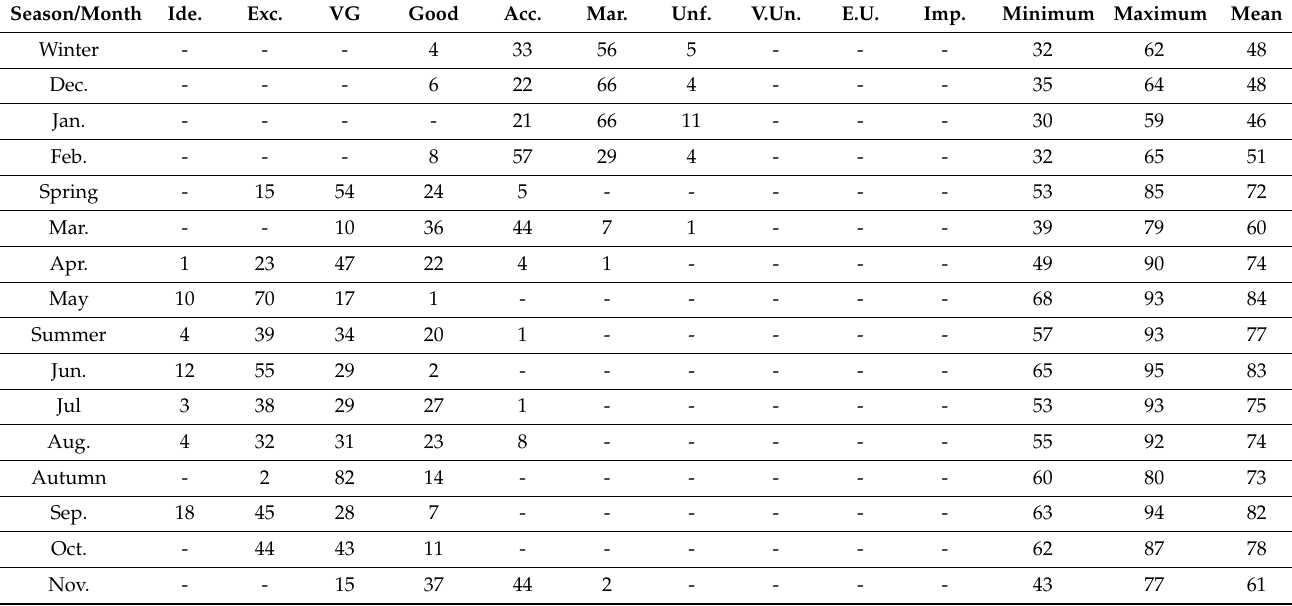
Table 3. Number of stations in TCI class* and the summary of TCI